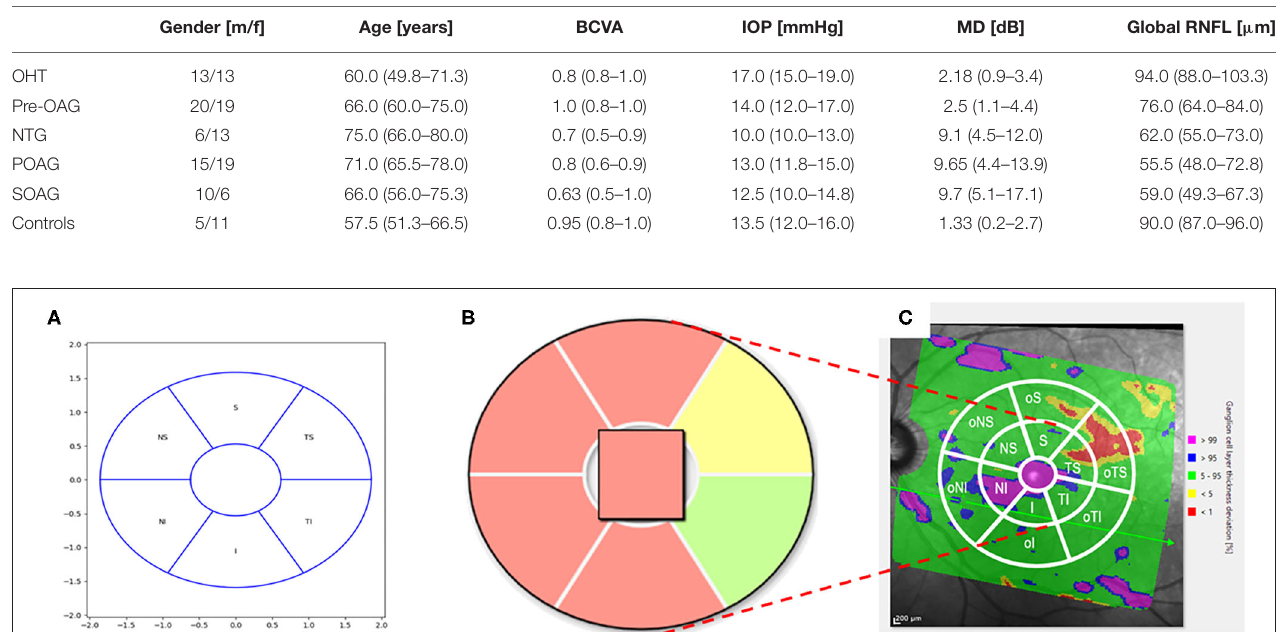
TABLE 2 | Demographic data: median and quartiles [of all subgroups (OHT, pre-OAG, POAG, NTG, SOAG, controls); Gender [m/f]], Age [years], BCVA, IOP [mmHg], MD [dB], and RNFL [ µ m].